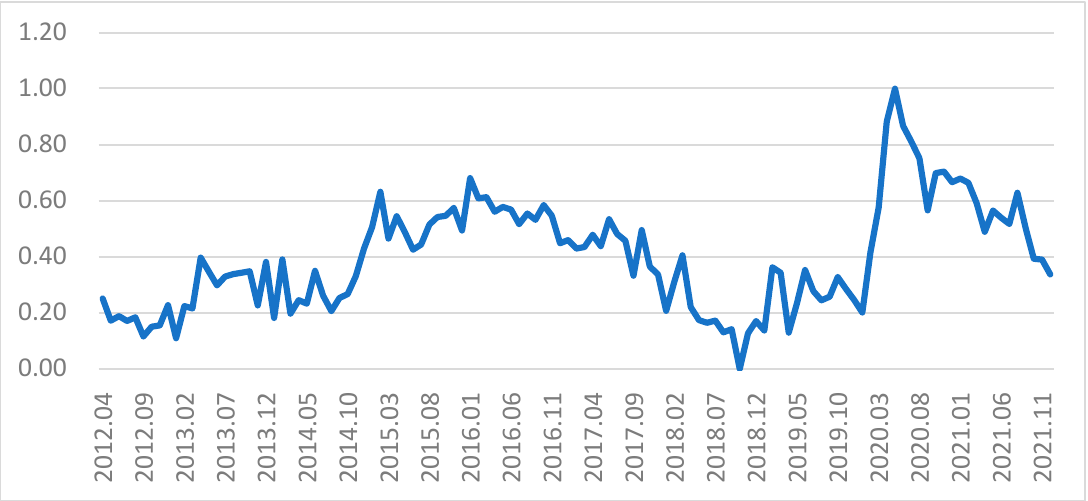
Figure 2. Industry Crisis Index Trend of Coke Briquettes and Petroleum Products.